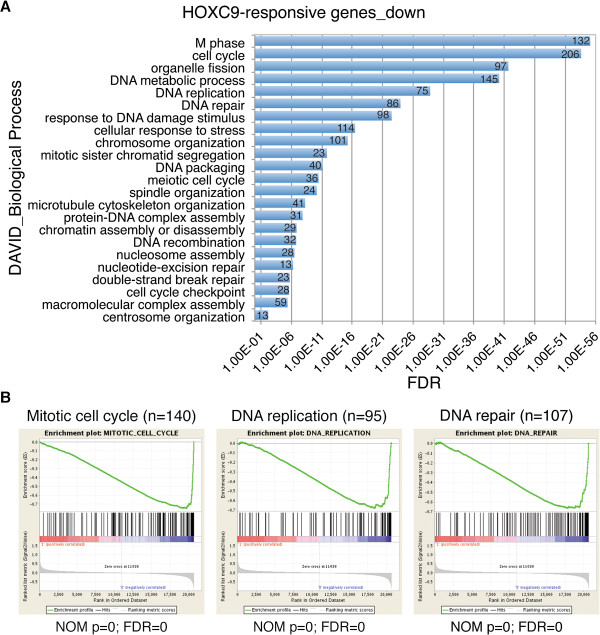
Global downregulation of cell cycle and DNA repair genes by HOXC9. (A) DAVID analysis of downregulated HOXC9-responsive genes for enriched GO biological process categories (enrichment fold > 2.0; FDR <1%). The number of genes for each biological process category is indicated. (B) GSEA showing significant enrichment of gene sets involved in mitotic cell cycle, DNA replication and DNA repair among the genes downregulated by HOXC9.